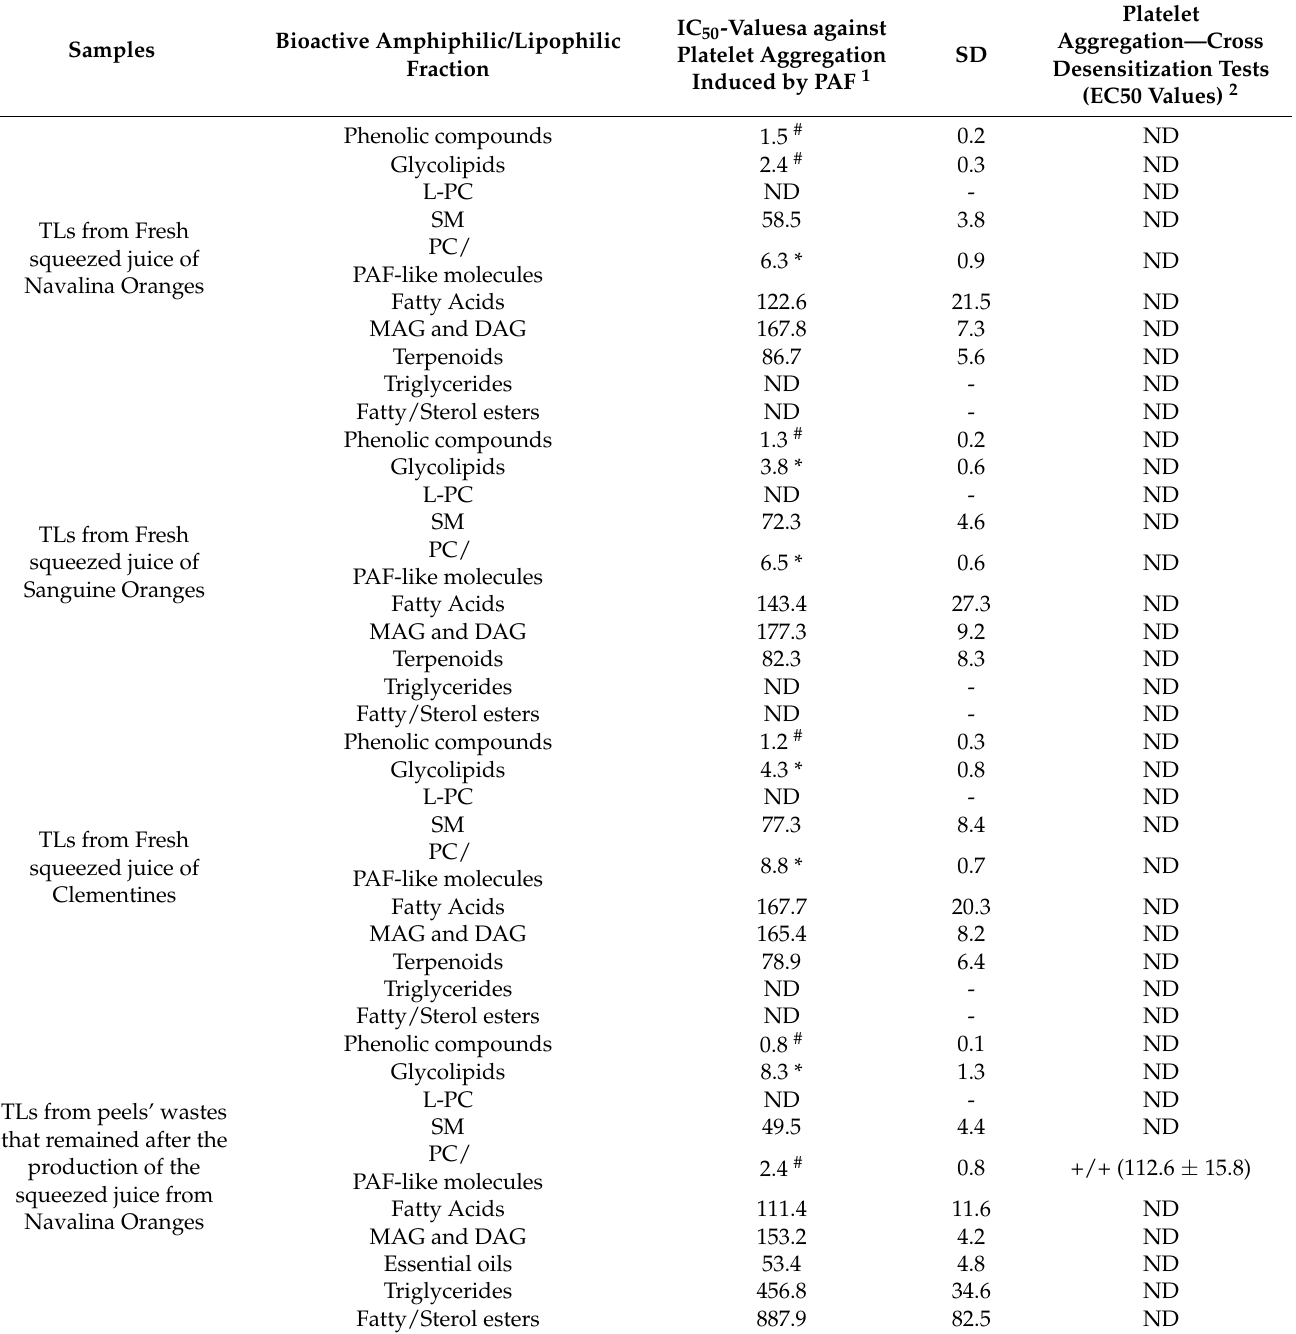
Table 2. In vitro bioactivities (antagonistic/inhibitory effects and agonistic/aggregatory effects) of the most bioactive HPLC-derived amphiphilic and lipophilic fractions of TLs from fresh squeezed juices of Navalina and Sanguine orange varieties, of clementines and from their by-products (peels’ wastes), against PAF -induced platelet aggregation. Biological assays were performed several times to ensure